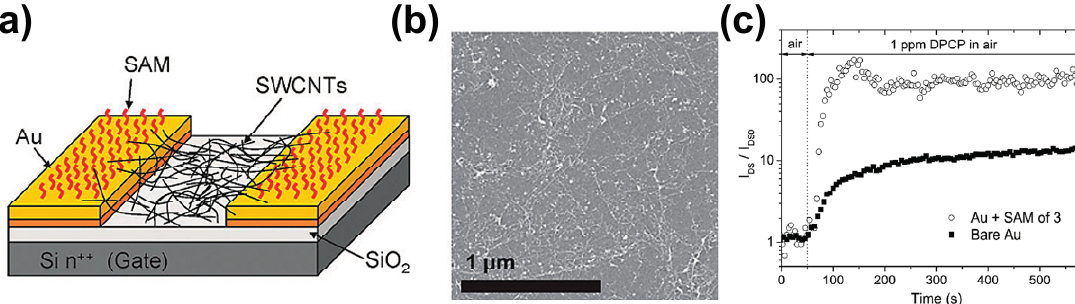
Figure 7. ( a ) Schematic structure of the CNT FET with functionalized gold electrodes; ( b ) SEM image of the SWNT network; ( c ) Normalized response to the CNT